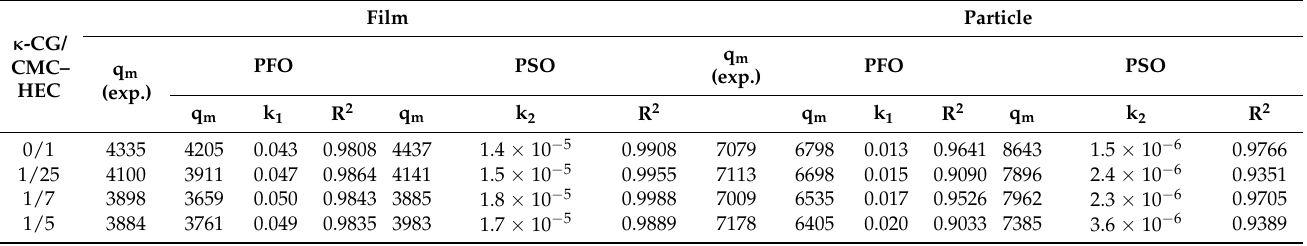
Figure 10. Effect of the absorption time on the water-absorption capacity of the hydrogel particles with different compositions in deionized water at ( A , C ) pH 3 and (B, D) pH 11 at 25 ◦ C. The experimental data were fitted with the ( A , B ) nonlinear PFO and ( C,D ) PSO kinetic models. Table 4. Kinetic-model parameters obtained using the nonlinear PFO and PSO models for the water absorption onto the dried gels in deionized water (pH 3 and 11) at 25 °C.